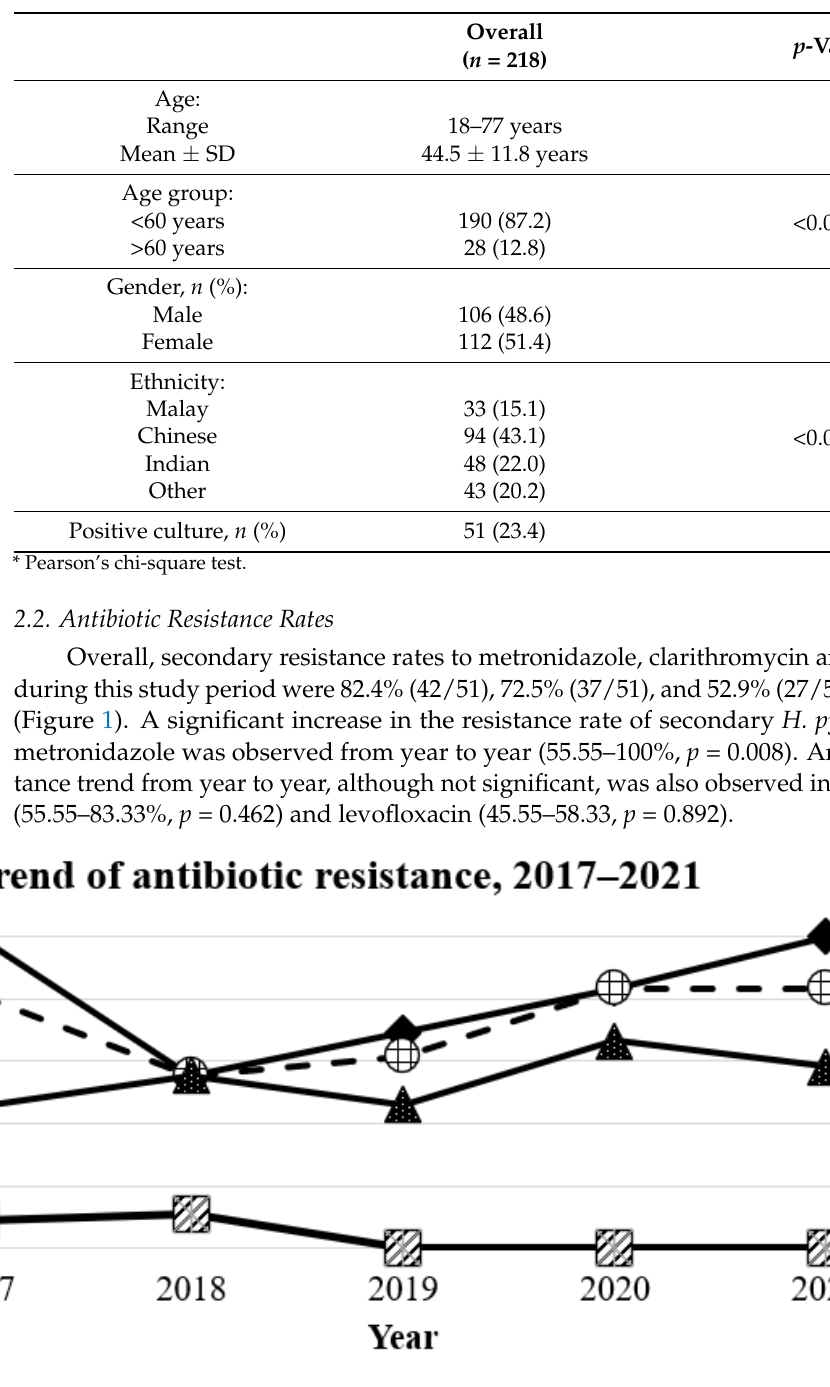
Table 1. Demography of patients.